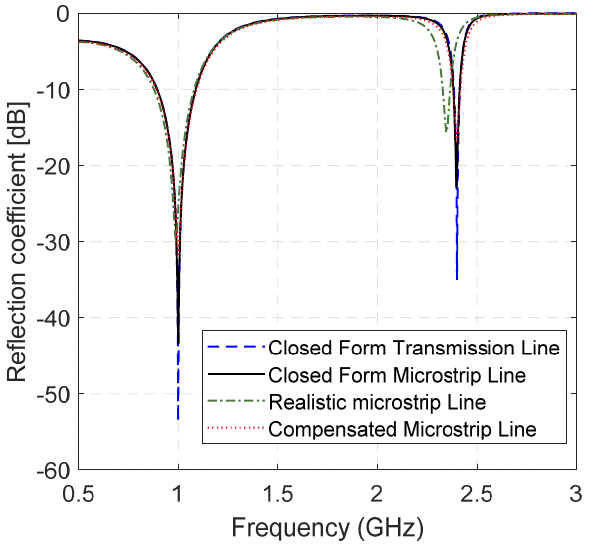
Figure 6. Comparison of simulative results for four circuit models of the experimental matching circuit.